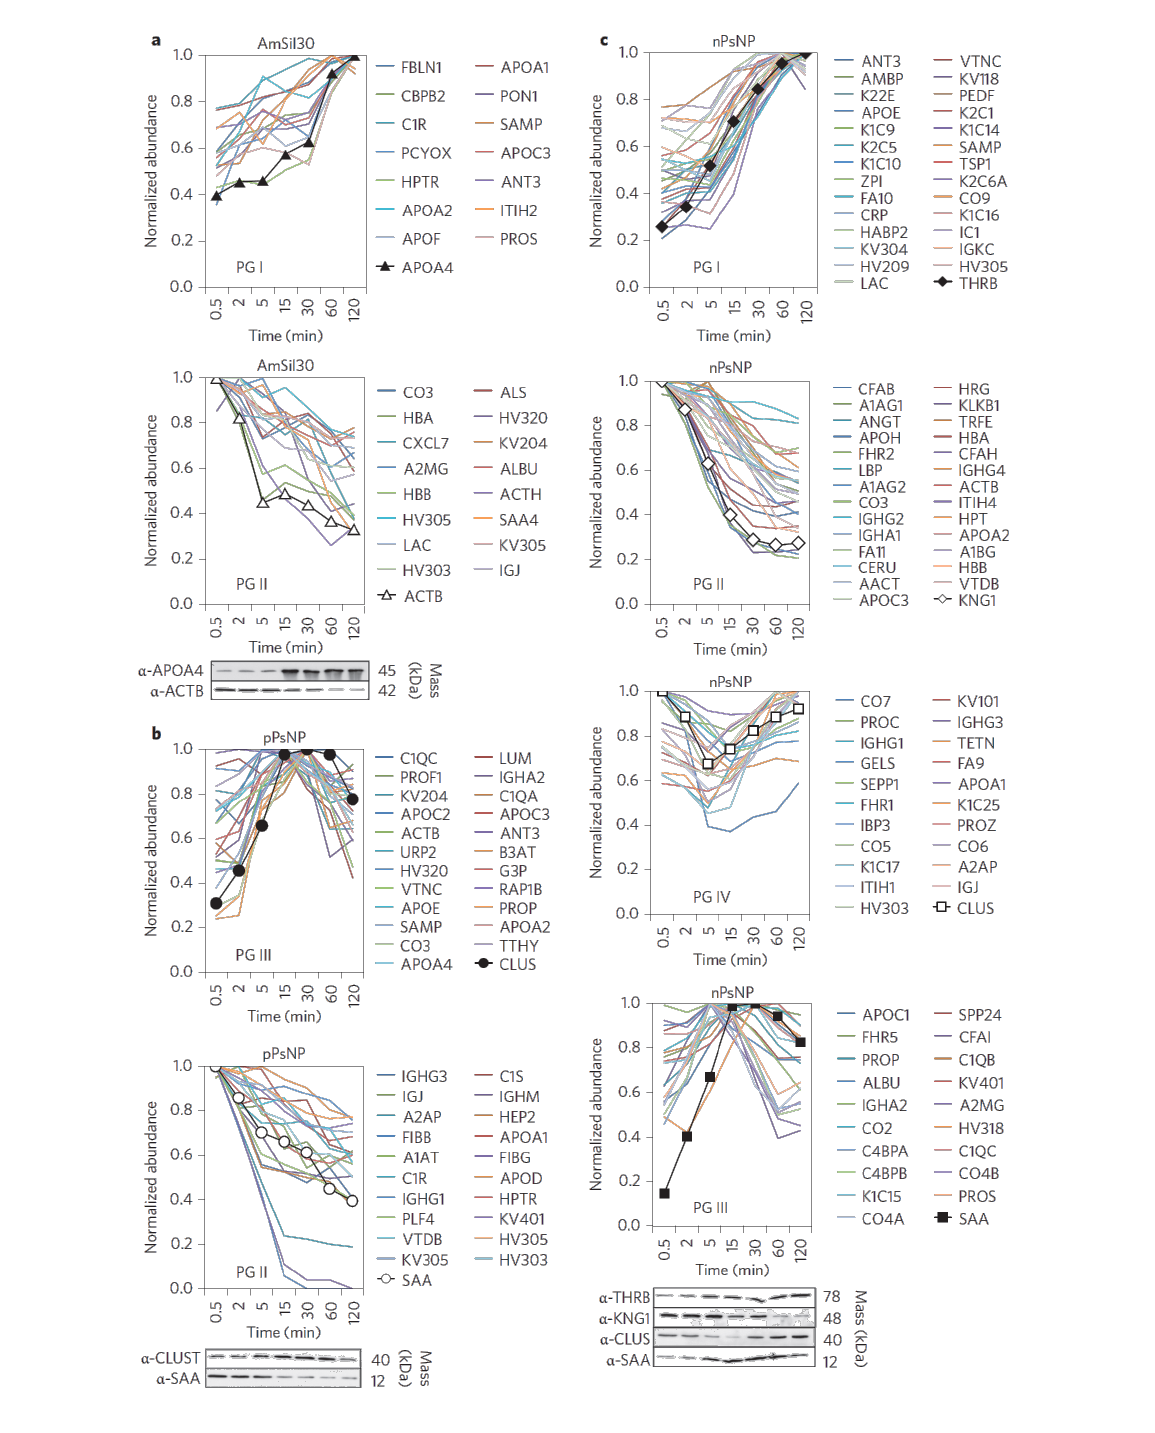
Figure 6: Tenzer et al. [10] revealed in a correlation analysis distinct kinetic protein-binding modalities during the temporal evolution of the serum protein corona. (a–c): Protein abundance profiles of AmSil30 (SiNP), time smoothes and normalized signals. (a): pPsNPs (polystyrene NP) and (b): nPsNPs (polystyrene NP) (c): NP coronae were classified into four groups by correlation analysis and relative values were normalized to the maximum amount across all time points for each protein. Protein groups PG I and PG II showed increasing or decreasing binding over time, respect- ively. PG III, ‘Peak’ proteins, display low abundance at the beginning of plasma exposure and at later time points, but higher (peak) abundance at intermediate time points. PG IV proteins show the opposite behavior, with a high abundance at early and late time points, but low abundance at inter- mediate time points. Profiles were verified independently for representative candidates (marked by symbols) by immunoblot analysis. Reproduced with permission from [10]. Copyright 2013 Nature Publishing